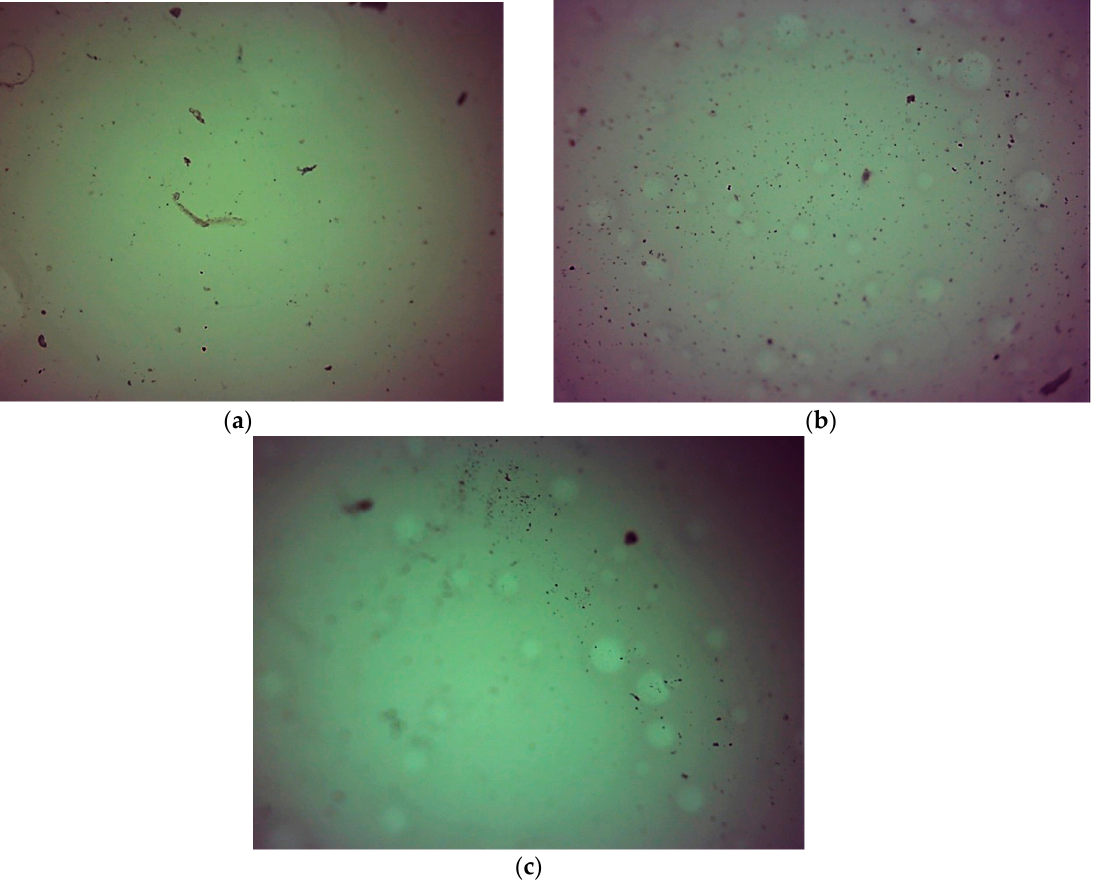
Figure 12. Optical images of hydrogels obtained using PEGDA 575: ( a ) 1.5 mL, ( b ) 2.0 mL, and ( c ) 2.5 mL (magnification 40×).